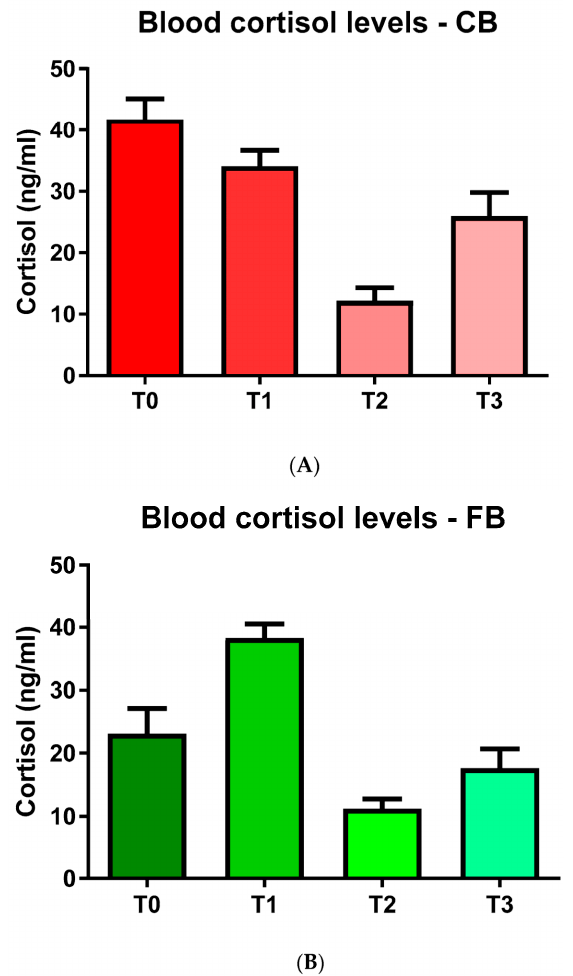
Figure 3. Blood cortisol levels (mean values ± SD) in the ( A ) compost barn (CB) and the ( B ) freestall barn (FB) groups.